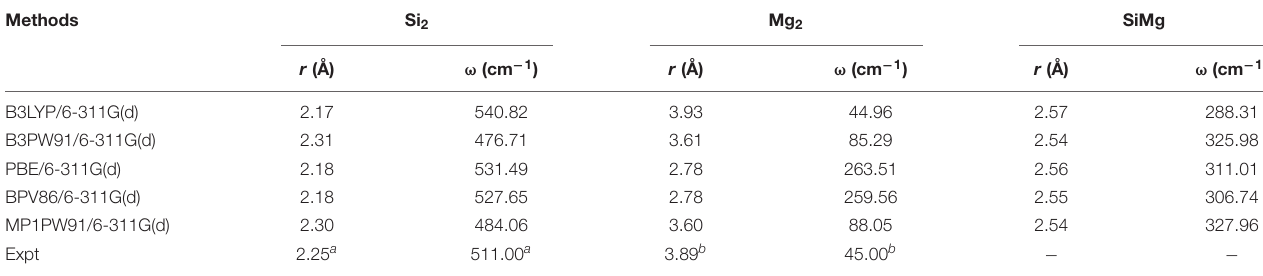
TABLE 1 | Calculated values of bond length r (Å), frequency ω (cm − 1 ) for Si 2 , Mg 2 , and SiMg isomers using different methods. Methods Si